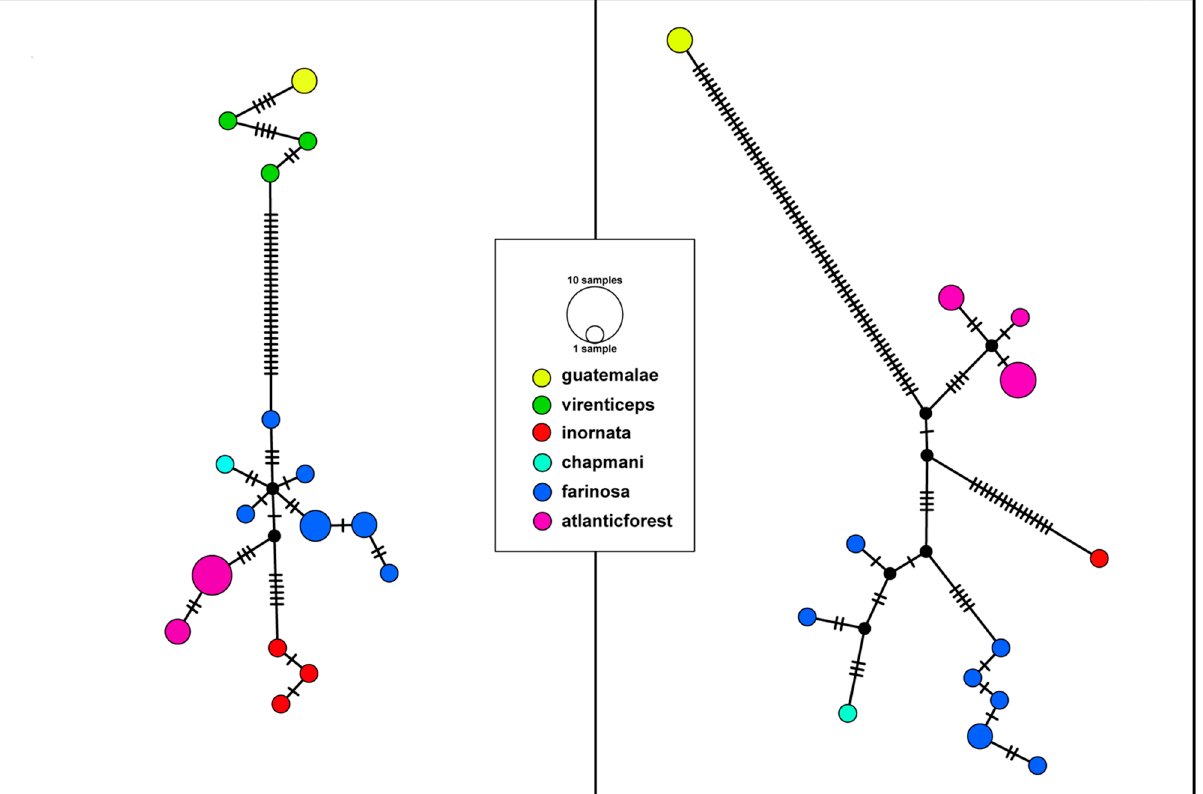
Figure 3. (Left panel) Median joining haplotype network based on CytB data. Size of each circle corresponds to the number of individuals sharing that haplotype and color to each clade. Ticks on each branch represent the number of sequence differences between each haplotype. (Right panel) Median joining haplotype network based on 4 mitochondrial genes (CytB, ND2, 12S, 16S). Size of each circle corresponds to the number of individuals sharing that haplotype and color to each clade. Ticks on each branch represent the number of sequence differences between each haplotype.